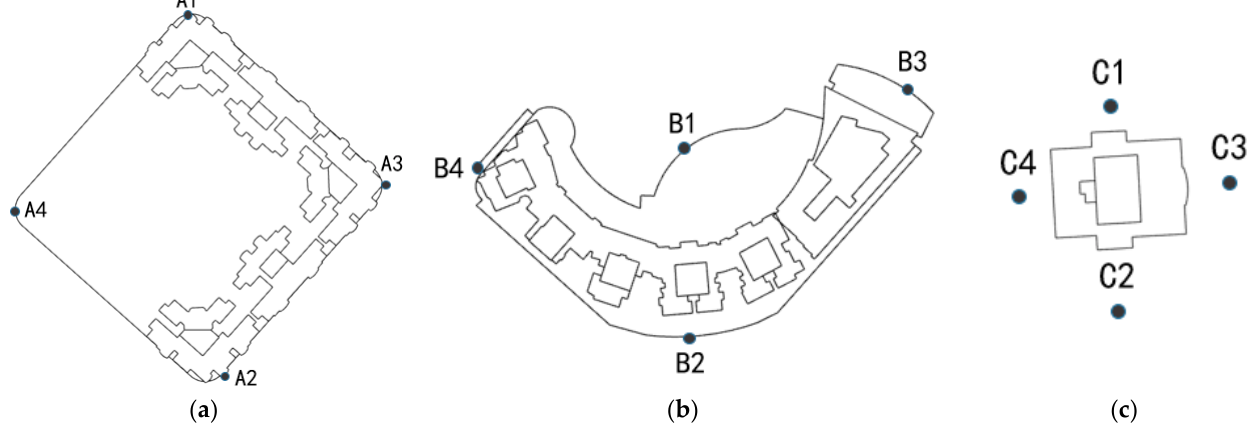
Figure A9. Schematic diagram of typical plane measuring point locations: ( a ) L-shaped splicing plate-type typical plane; ( b ) U-shaped splicing plate-type typical plane; and ( c ) Standard floor plan for a single-family home in the point style.